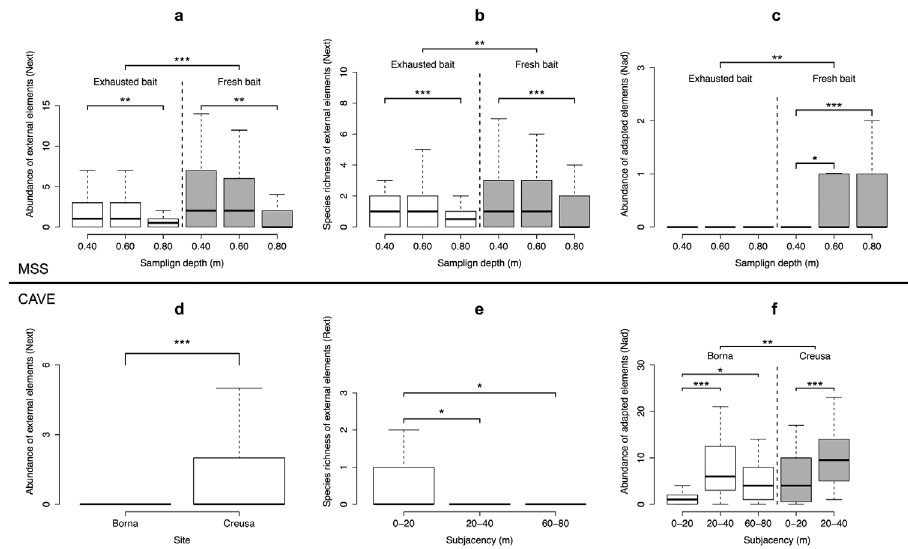
Figure 5. Boxplots showing the results of the regression analysis of the MSS ( a–c ) and the cave ( d–f ) data. Outlying values are not shown. Significance codes: < 0.001 ***; < 0.005 **; < 0.05 *.